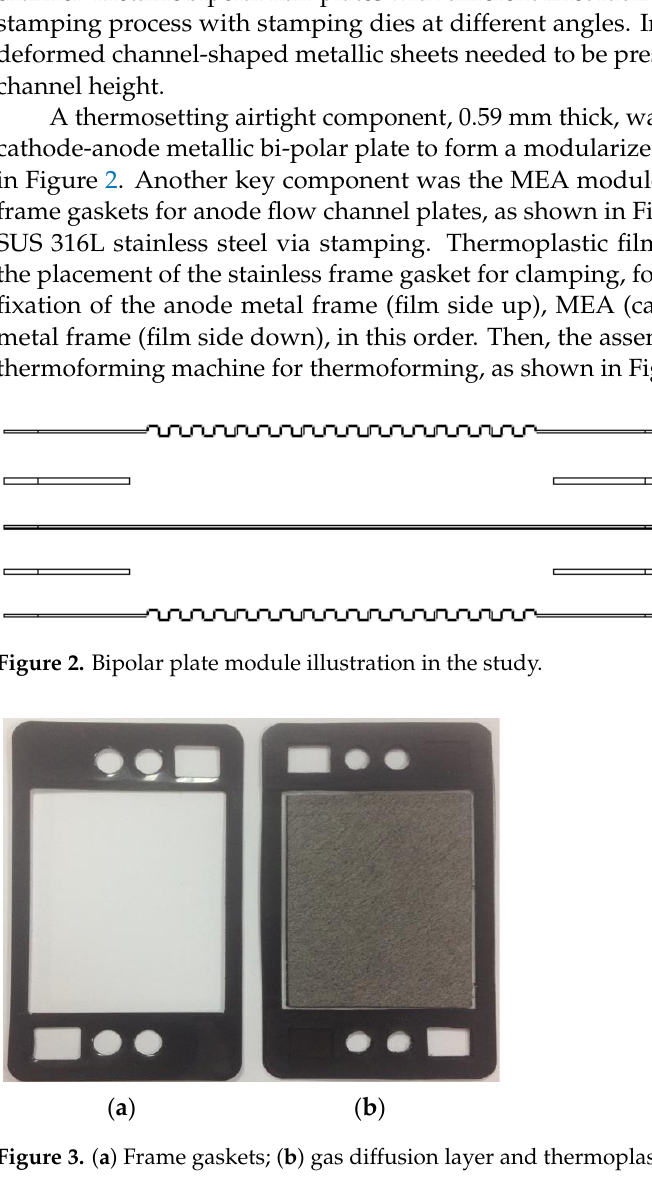
Figure 2. Bipolar plate module illustration in the study